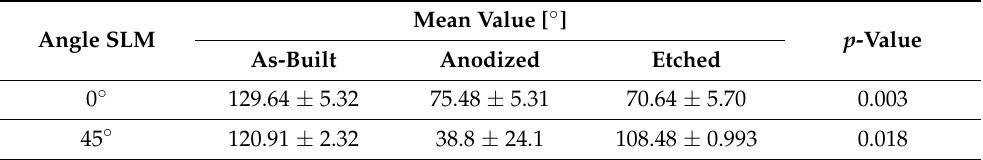
Table 2. CA measurements and statistical evaluation of the as-built, anodized and etched samples.